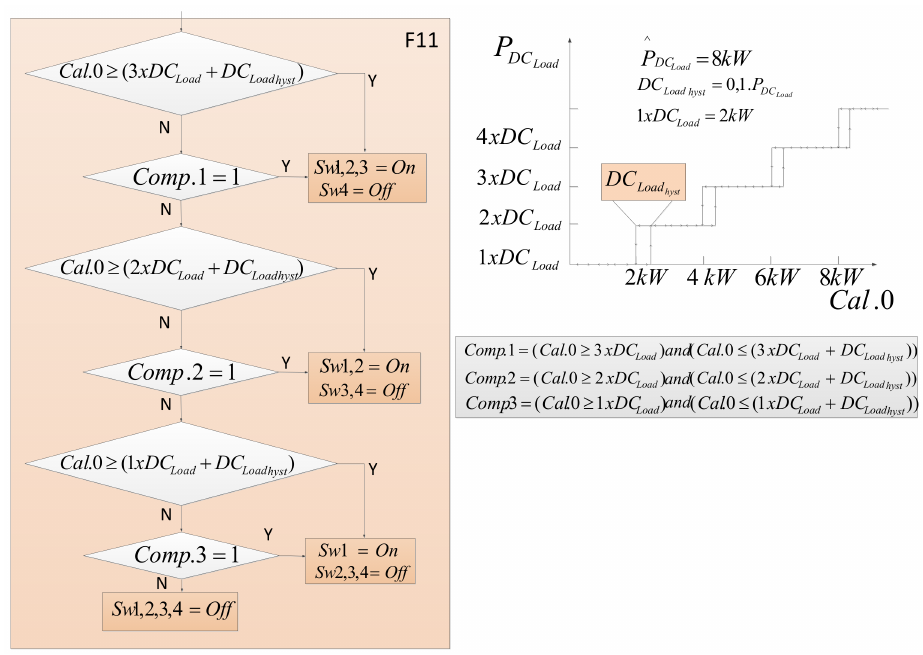
Figure 4. Load shedding